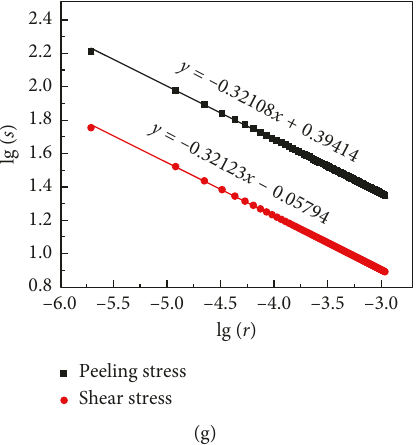
Figure 5: Fitting straight line and results. (a) RL 0 joints, (b) RL 1 joints, (c) RL 2 joints, (d) RL 3 joints, (e) RL 4 joints, (f) RL 5 joints, and (g) RL 6 joints.